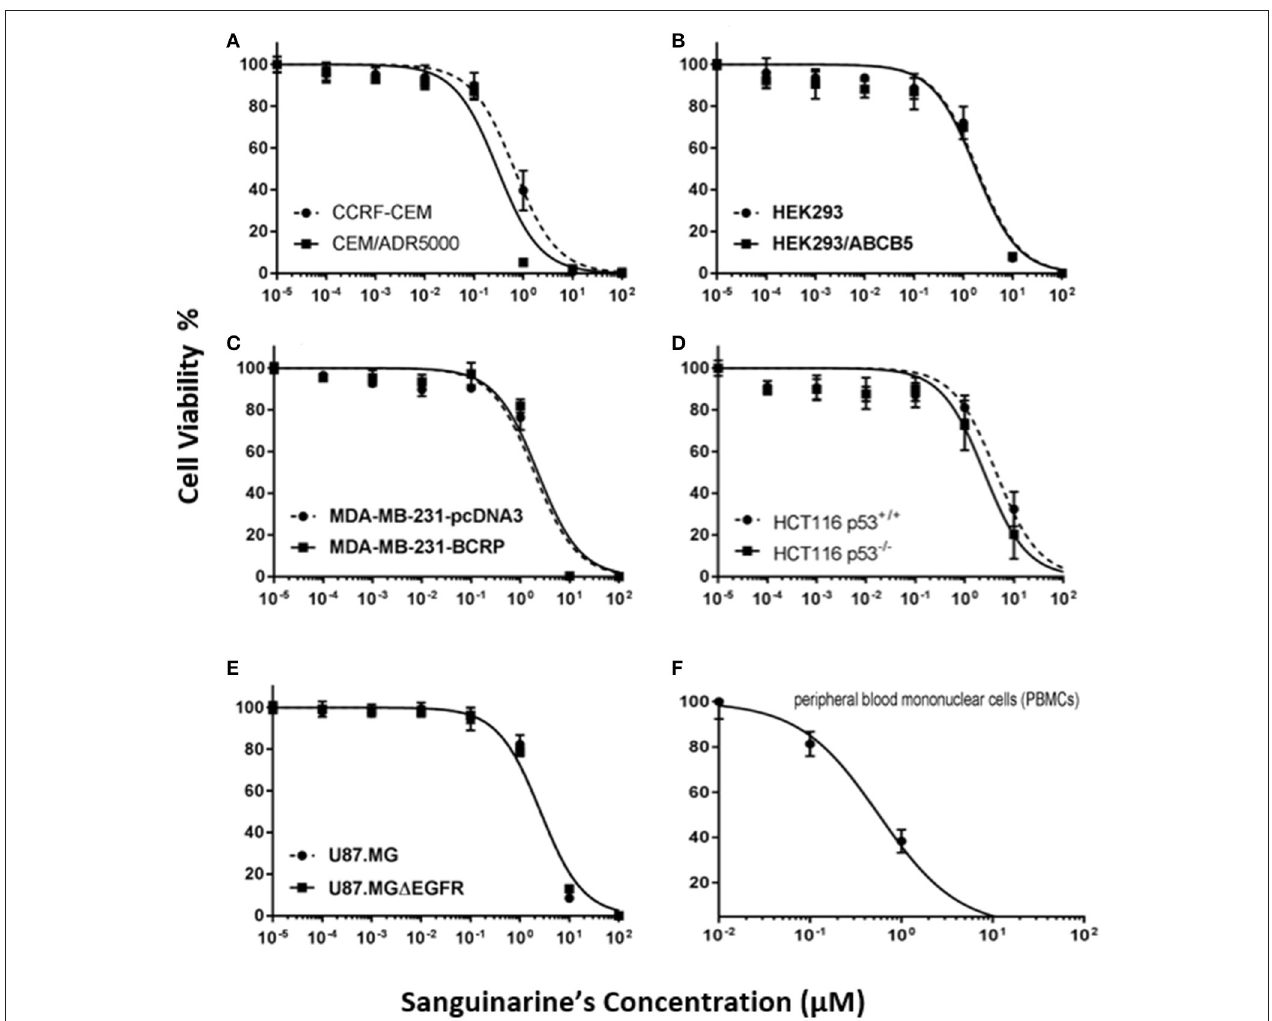
FIGURE 1 | Dose response curves of sanguinarine. (A) Cytotoxicity of sanguinarine toward drug-sensitive parental CCRF-CEM tumor cells and their P-glycoprotein (MDR1/ABCB1)-expressing, multidrug-resistant subline, CEM/ADR5000. (B) Cytotoxicity of sanguinarine toward HEK293 cells and their ABCB5-transfectant subline, HEK293/ABCB5 as determined by resazurin assays. (C) Cytotoxicity of sanguinarine toward MDA-MB-231-pc DNA cells and their BCRP-transduced subline, MDA-MB-231-BCRP as determined by resazurin assays. (D) Cytotoxicity of sanguinarine toward HCT116 p53 + / + cells and their p53 − / − knockout subline,